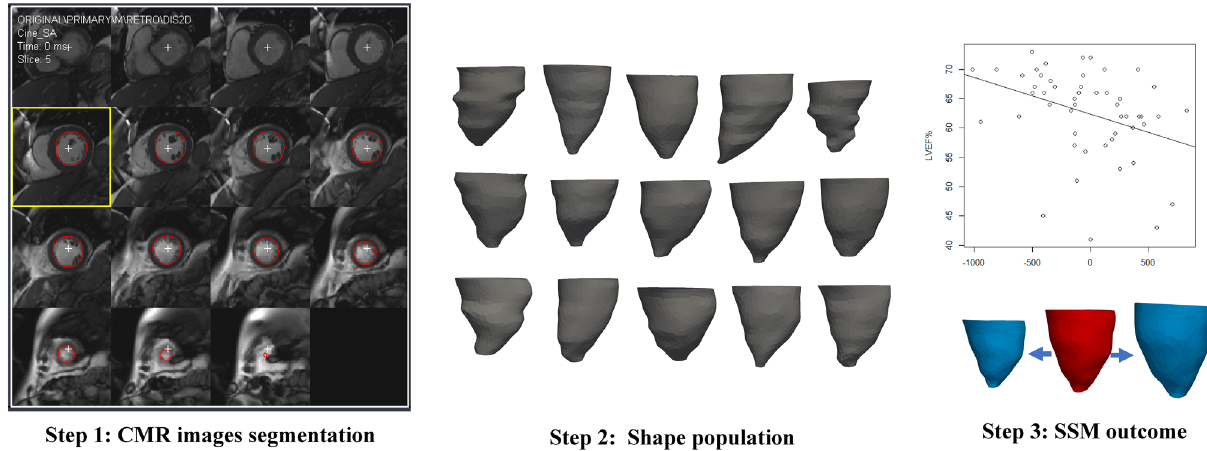
Figure 1. Statistical shape modelling (SSM) framework. Step 1: Cardiovascular magnetic resonance (CMR) cine short axis images segmentation to create 3D volume meshes of LV endocardium (in red) at end-diastole using Segment software; Step 2: Indication of the reconstructed shape population; Step 3: A shape mode showing a deformation as being correlated to LVEF%, exemplifying the feasibility of statistical analysis to capture parameters of